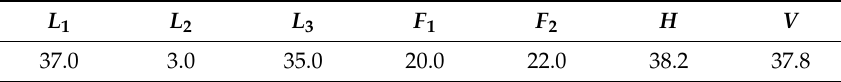
Table 3. Final values of the stator’s main parameters